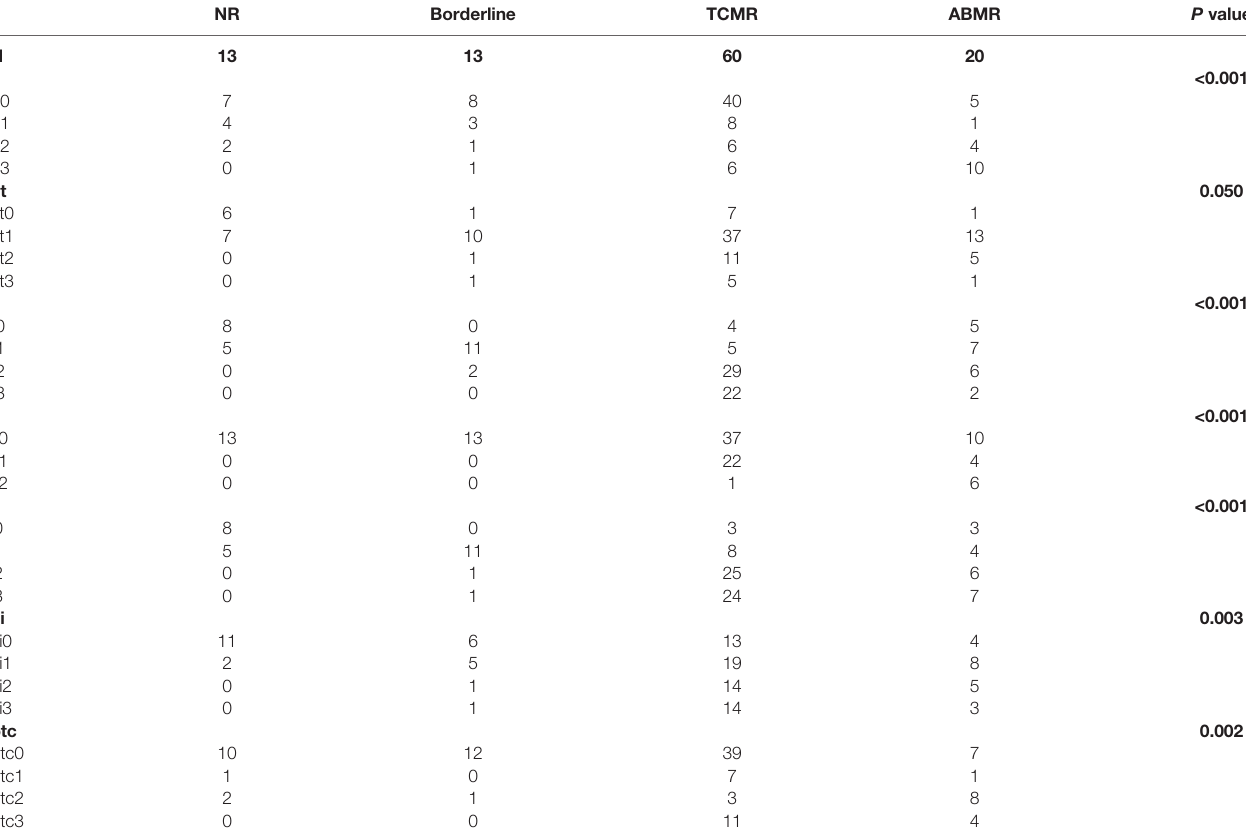
TABLE 2 | Banff lesion subelements in each group.